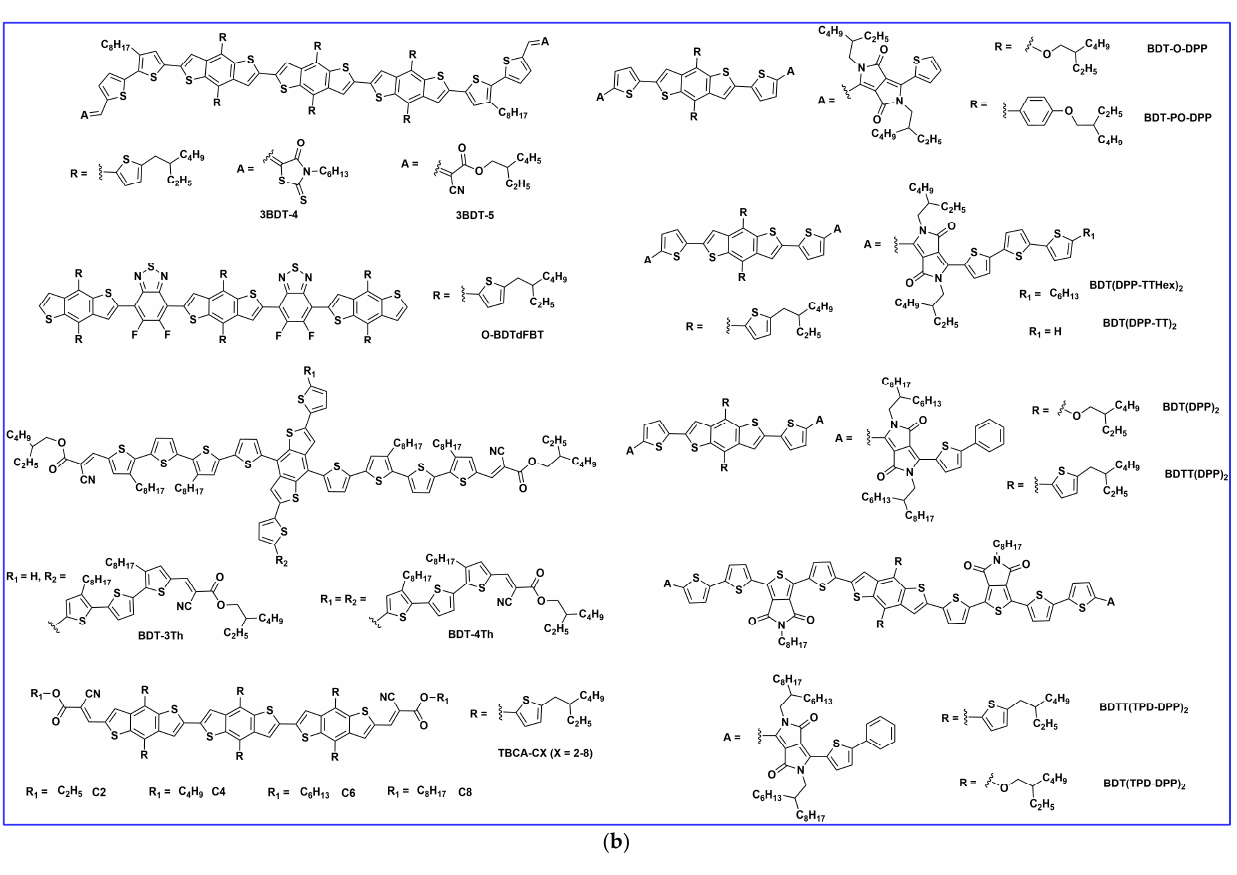
Figure 6. ( a ) BDT molecular structures with various combinations. ( b ) BDT molecular structures with various combinations. Table 4. Optoelectronic properties and device parameters for BDT-based ASM OSCs with various